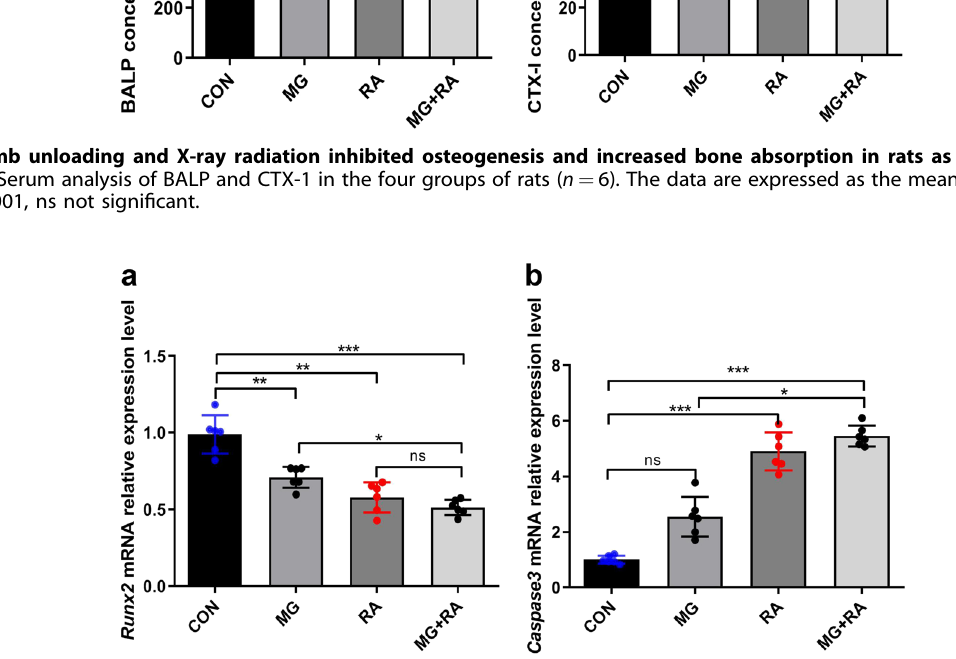
Fig. 7 Hindlimb unloading and X-ray radiation inhibited osteoblast differentiation and increased osteoblast apoptosis in rat femurs as evidenced by qRT-PCR analysis. a , b qRT-PCR analysis of Runx2 and Caspase-3 in the four groups of rat femurs ( n = 6). The data are expressed as the mean ± SD. * P < 0.05, ** P < 0.01, *** P < 0.001, ns not signi fi